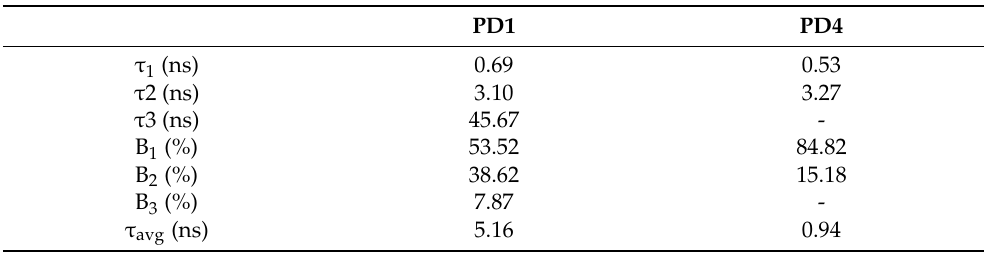
Table 1. Summary of TRPL decay fitting characteristics for the photodetectors PD1 and PD4 based on the decay